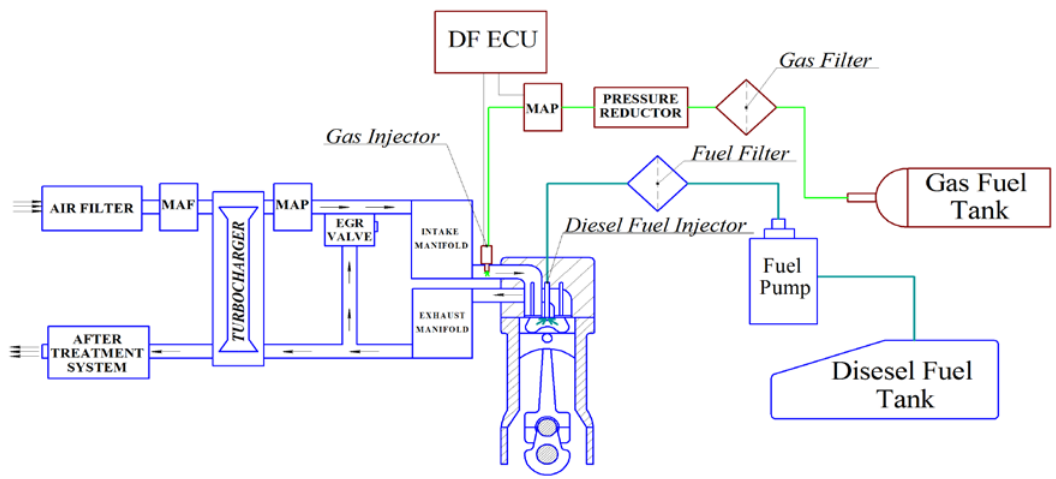
Fig. 2. Simple* overall scheme of Dual fuel mode in AJM 1.9 TDI (*Does not contain all electrical